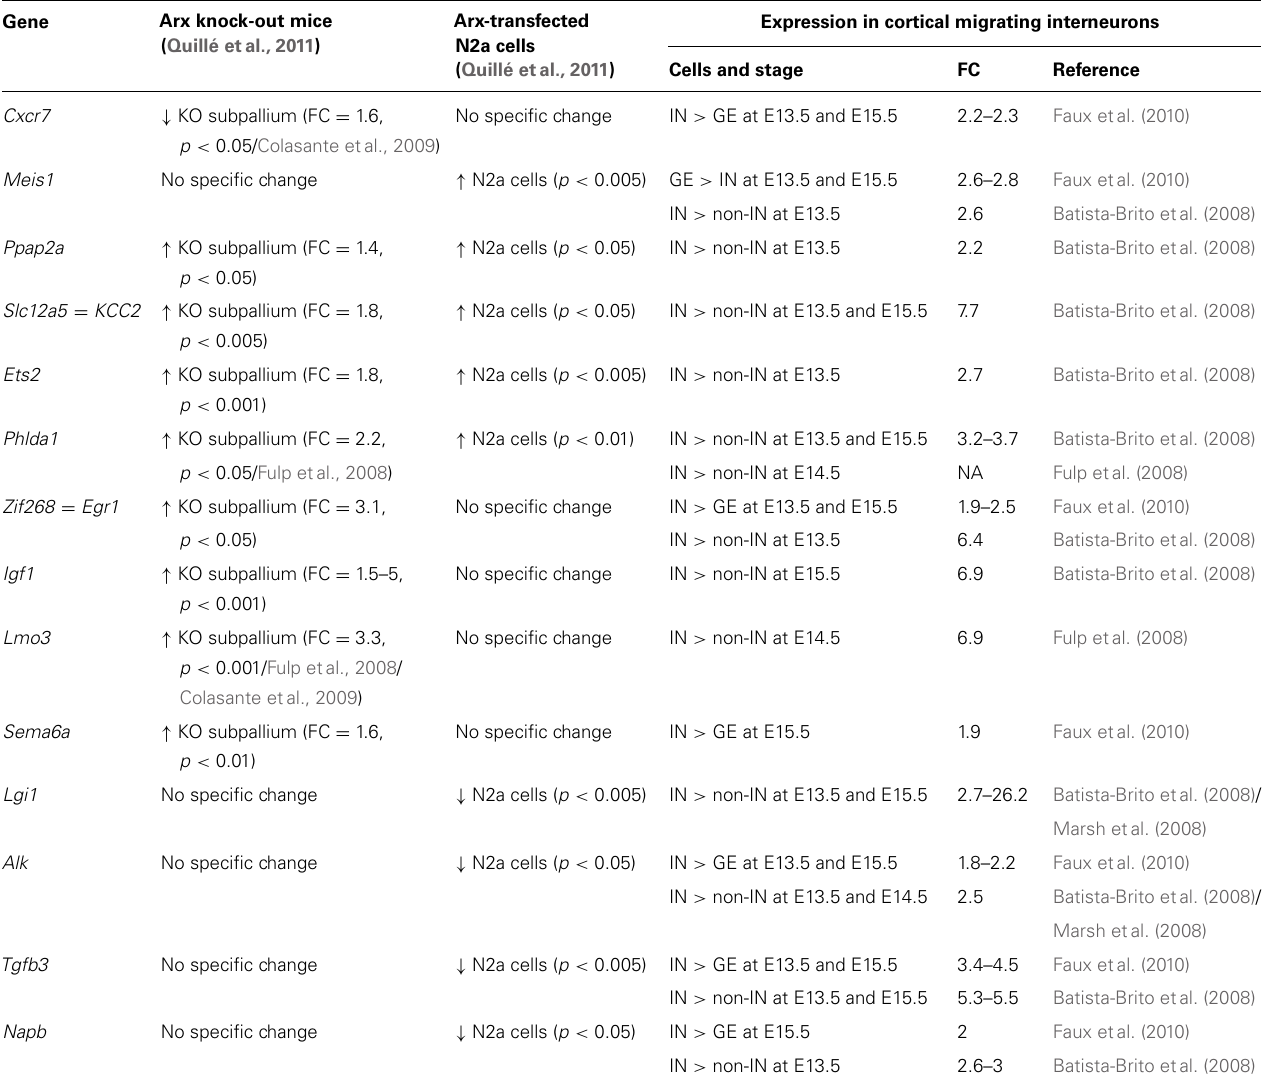
Table 2 | Examples ofArx-bound and regulated genes that are enriched in migrating cortical interneurons (IN) compared to neurons in ganglionic eminences (GE) and cortical non-interneurons (non-IN). Arx-transfected Expression in cortical migrating interneurons Gene Arx knock-out mice N2a cells (Quillé etal., 2011) Cells and stage FC (Quillé etal., 2011)